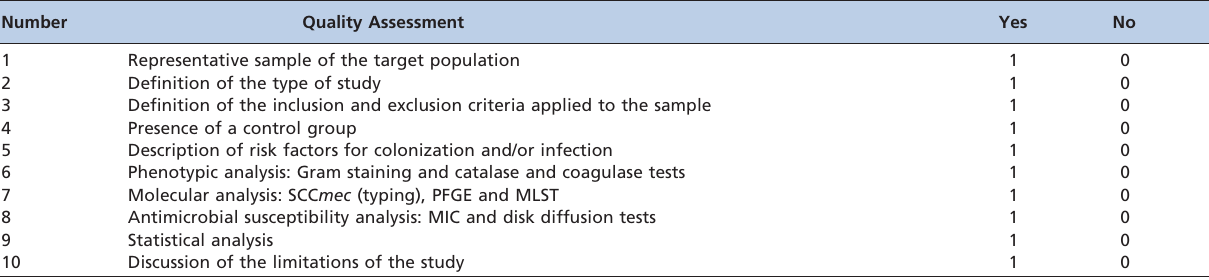
Table 1 - Quality evaluation criteria and their scores.